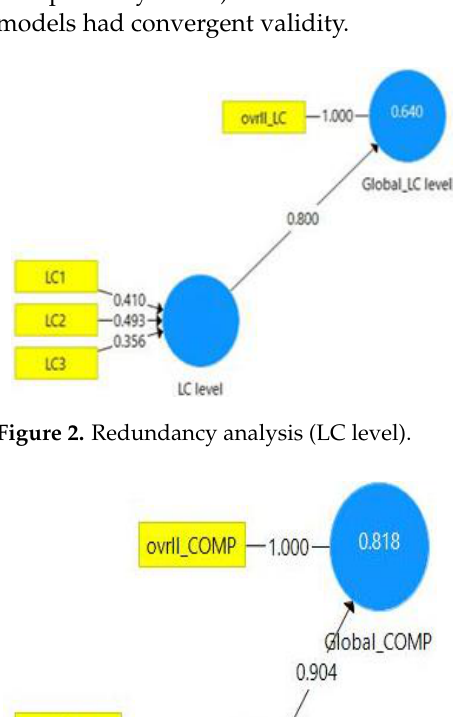
Figure 3. Redundancy analysis (Compatibility).